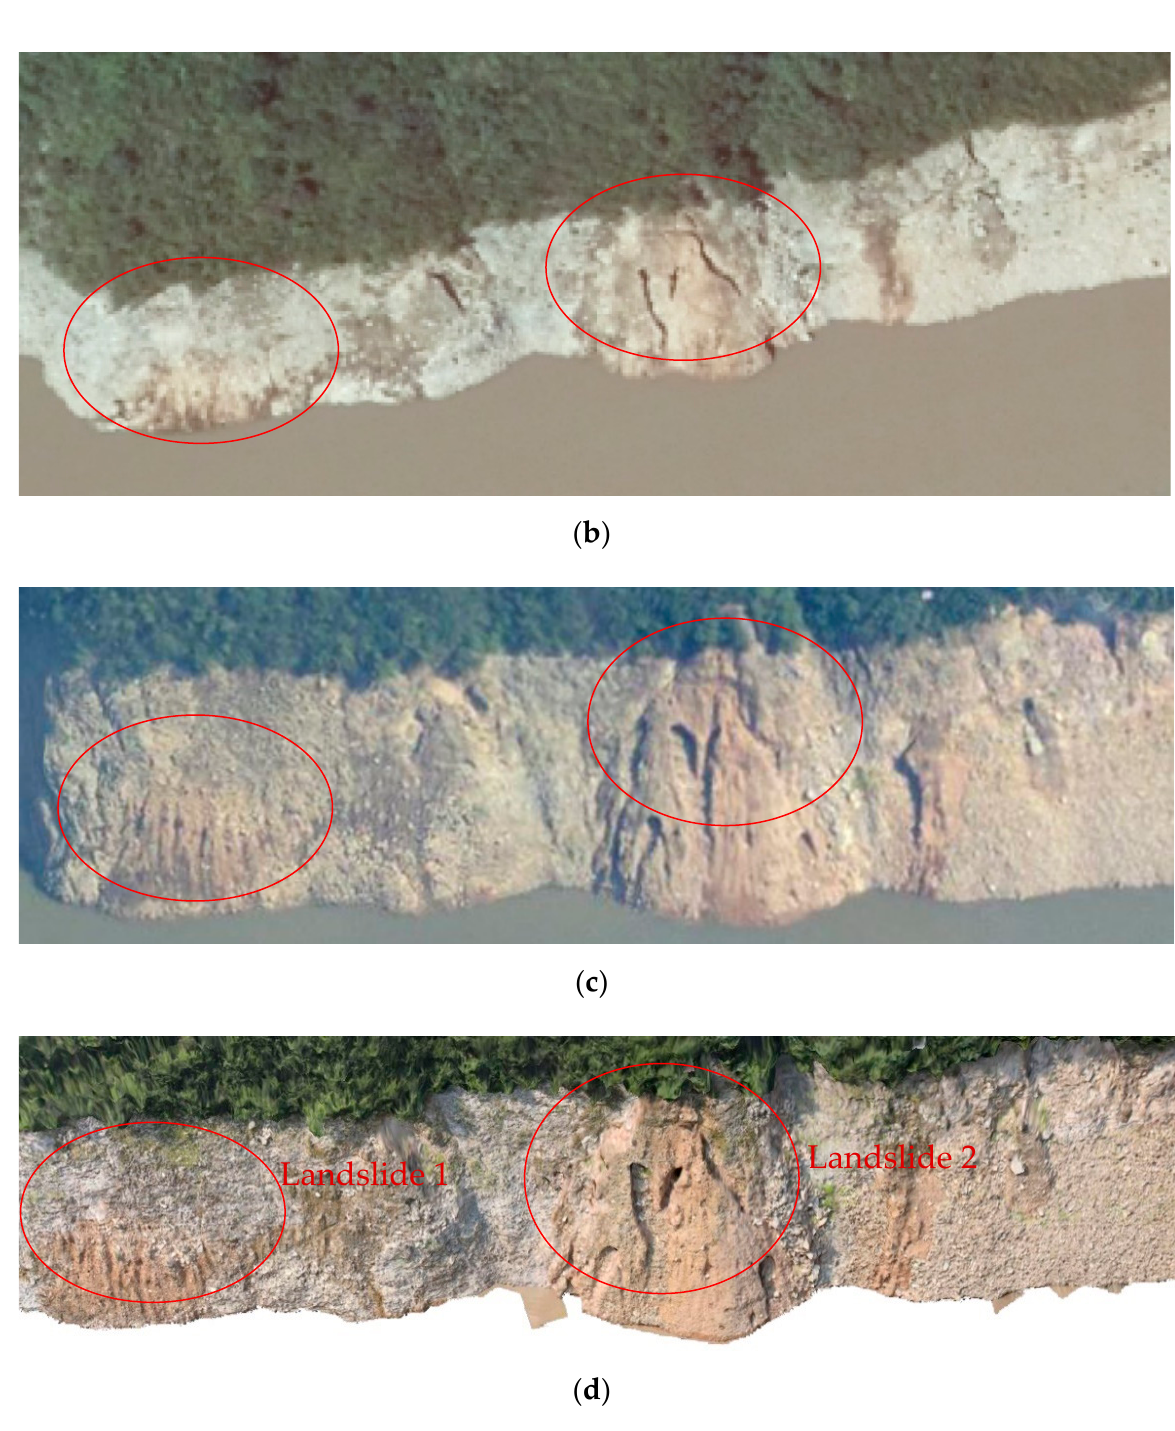
Figure 14. Small landslide depicted by different remote sensing data. ( a ) GF-2 satellite image; ( b ) aerial orthophotograph; ( c ) oblique photogrammetric 3D model; ( d ) shipborne photogrammetric 3D model. The area of landslide 1 is approximately 300 m 2 , length 10 m, width 30 m; the area of landslide 2 is approximately 600 m 2 , length 28 m, width 25 m.